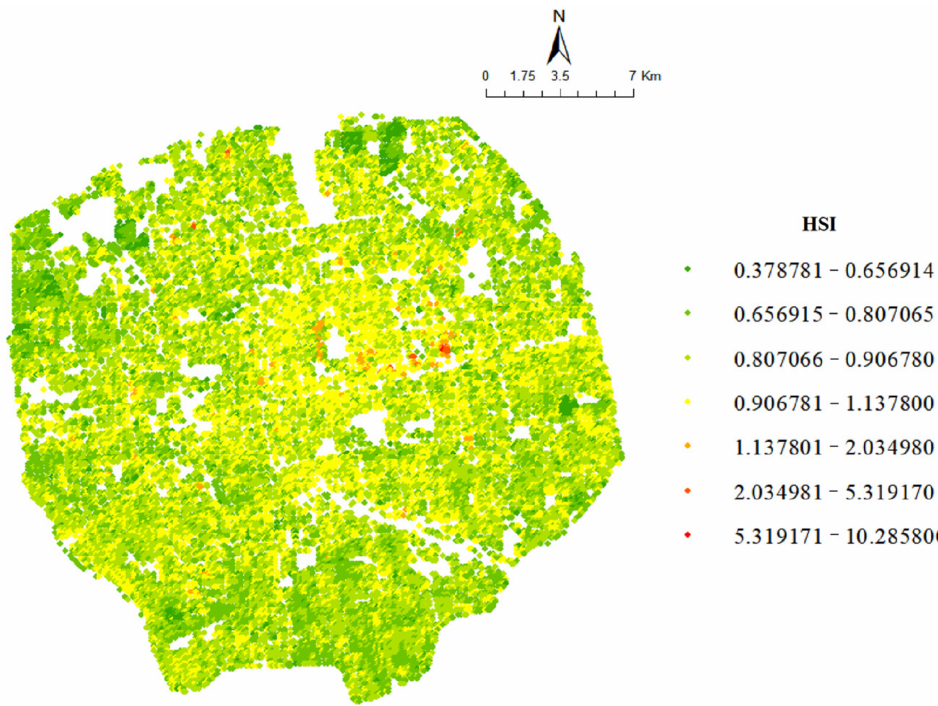
Figure 6. Spatial distribution of the human settlement index values within the Fifth Ring Road in